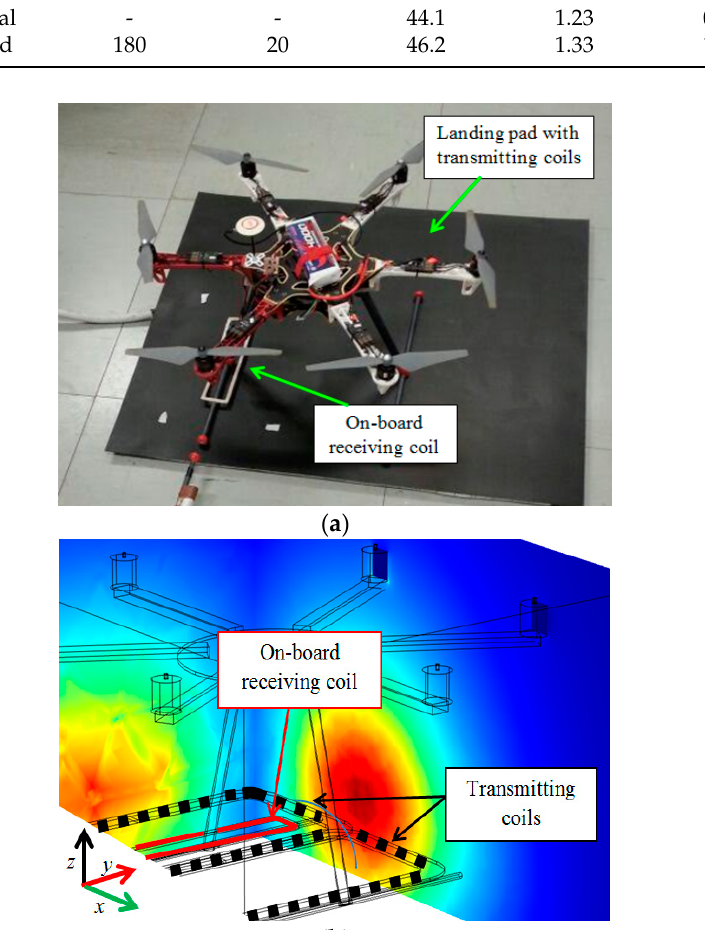
Figure 12. 3D model of the drone with WPT system for numerical simulation ( a ), demonstrator of the WPT system applied to a DJI F550 drone ( b ).